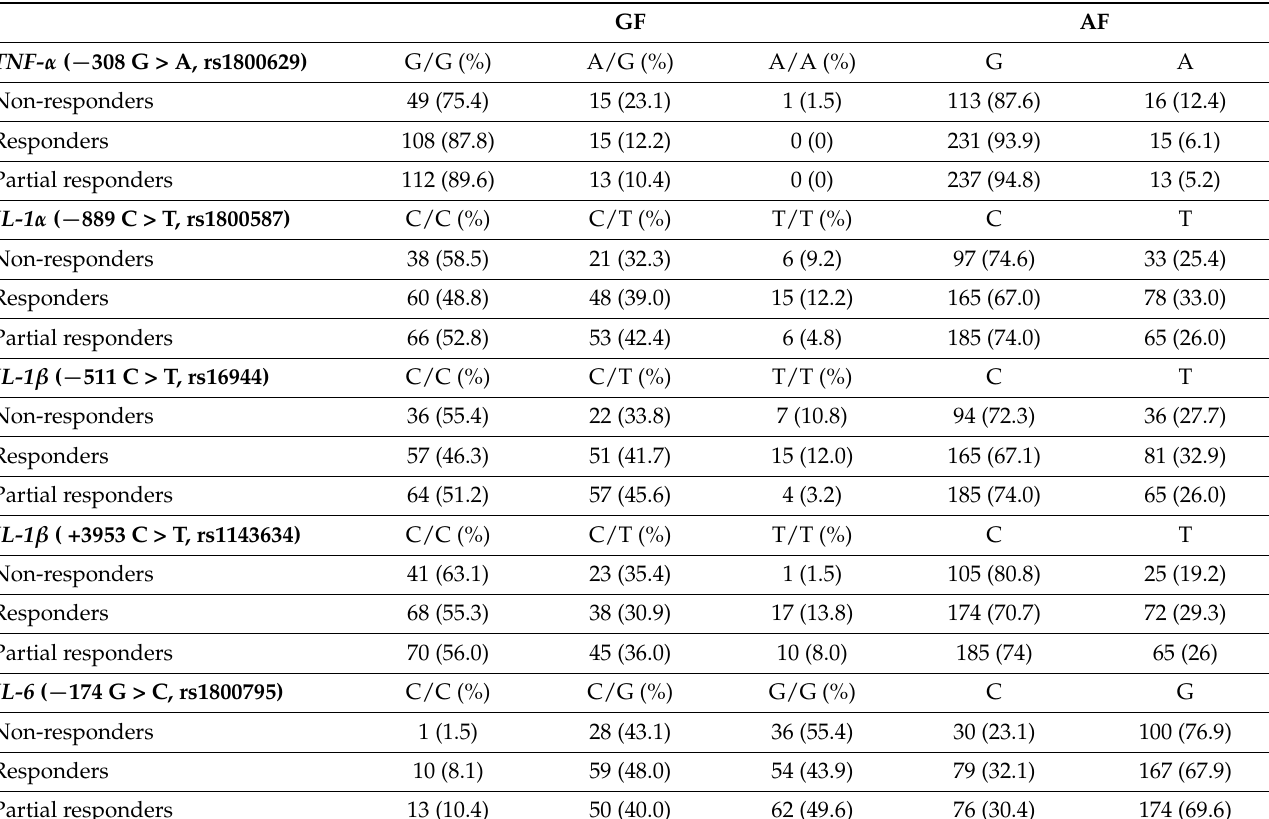
Table 2. Genotype frequencies (GF) and allele frequency (AF) of polymorphisms of TNF- α ( − 308 G > A, rs 1800629), IL-1 α ( − 889 C > T, rs 1800587), IL-1 β ( − 511 C > T, rs 16944 and +3953 C > T, rs 1143634), IL-6 ( − 174 G > C, rs 1800795), in non-responders, responders and partial responders to NSAIDs. Data are displayed as count and percentage.